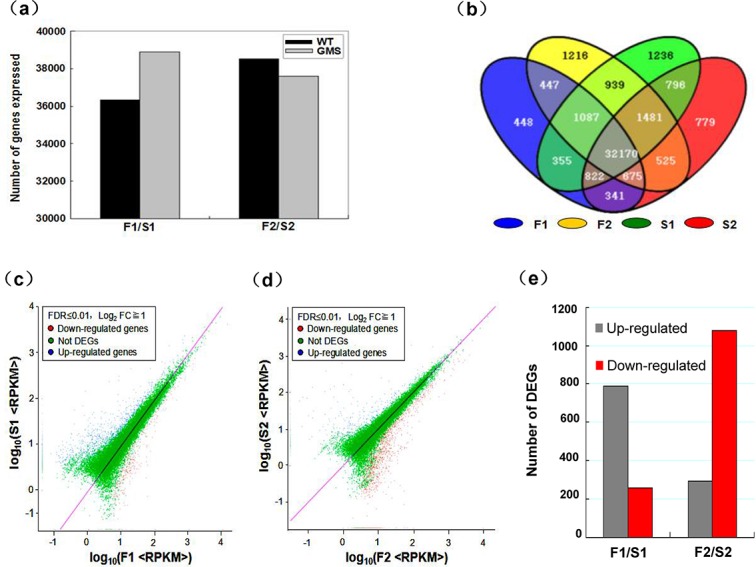
Transcriptome and differentially expressed gene (DEG) analysis of the wild-type and genic male sterile mutant buds.(a) shows the transcriptome sizes at two periods, from meiosis to the formation of tetrads, and from the release of microspores to the formation of spinescent protuberances in wild-type and genic MS mutant anthers, respectively. (b) shows the mutual overlaps of the two bud development stages in wild-type and genic male sterile mutant buds, and that of the two stages of each of the two buds. (c) and (d) show the expressed genes at the two stages in wild-type and genic MS mutant anthers. (e) shows the number of differentially expressed genes at the two stages in wild-type and genic MS mutant anthers.